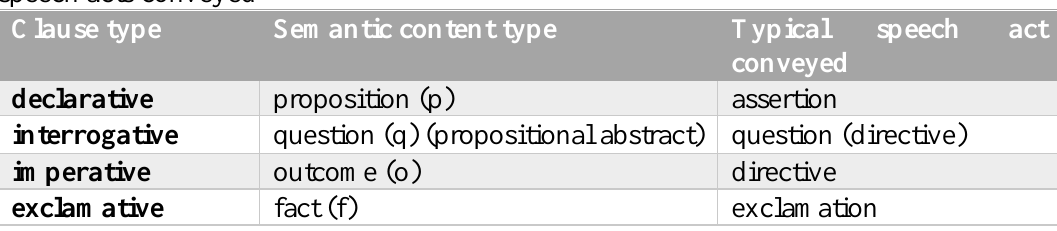
Table 1. Semantic content types according to Ginzburg and Sag (2000) and the typical speech acts